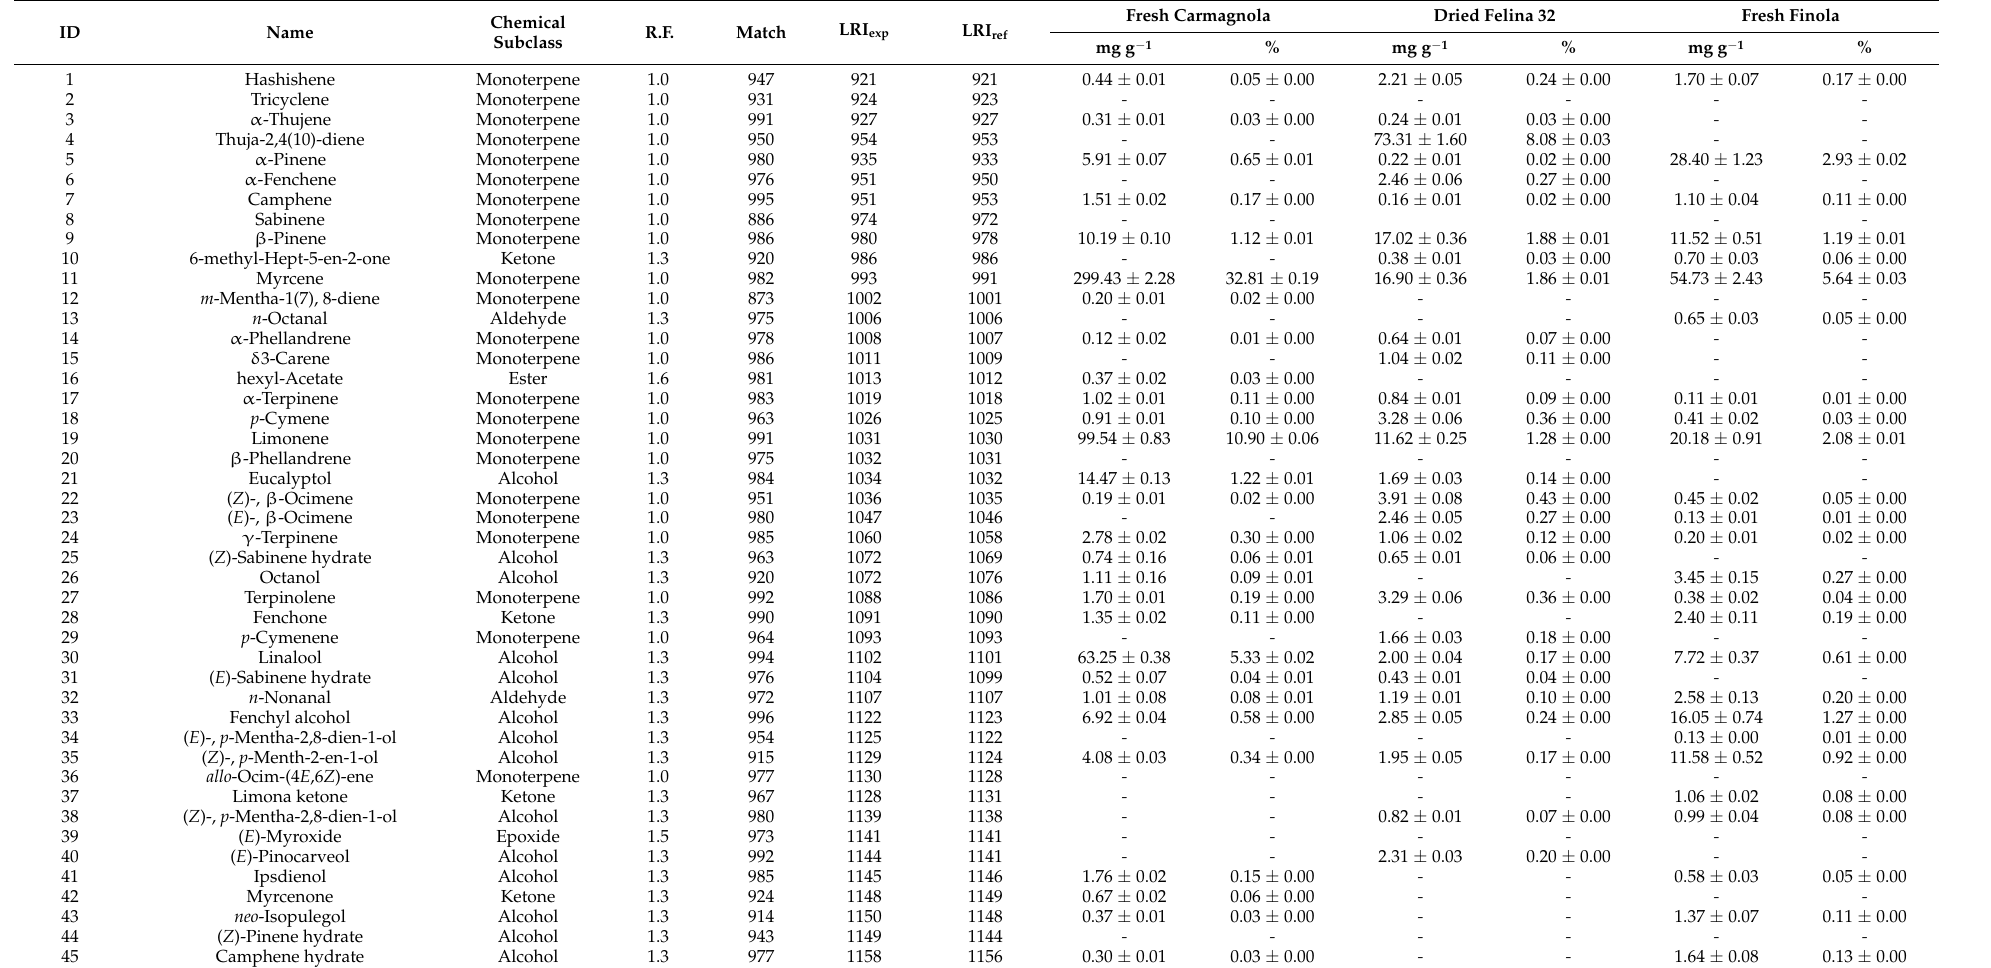
Table 2. List of volatile compounds detected in cannabis essential oils (EOs) distilled from inflorescences of Carmagnola (fresh), Felina 32 (dried) and Finola (fresh) cultivars. Abbreviations: R.F.: response factor; match: database spectral matching; LRI exp : experimental LRI; LRI ref : reference LRI. Quantitative results are expressed both in absolute manner (mg g − 1 ) and in relative percentages (%). The compounds are also grouped in monoterpene, sesquiterpene, diterpene and aliphatic hydrocarbons and as well as oxygenated compounds including aldehyde, alcohol, ester, ketone, epoxide, and cannabinoid. The cannabis EO yields are also